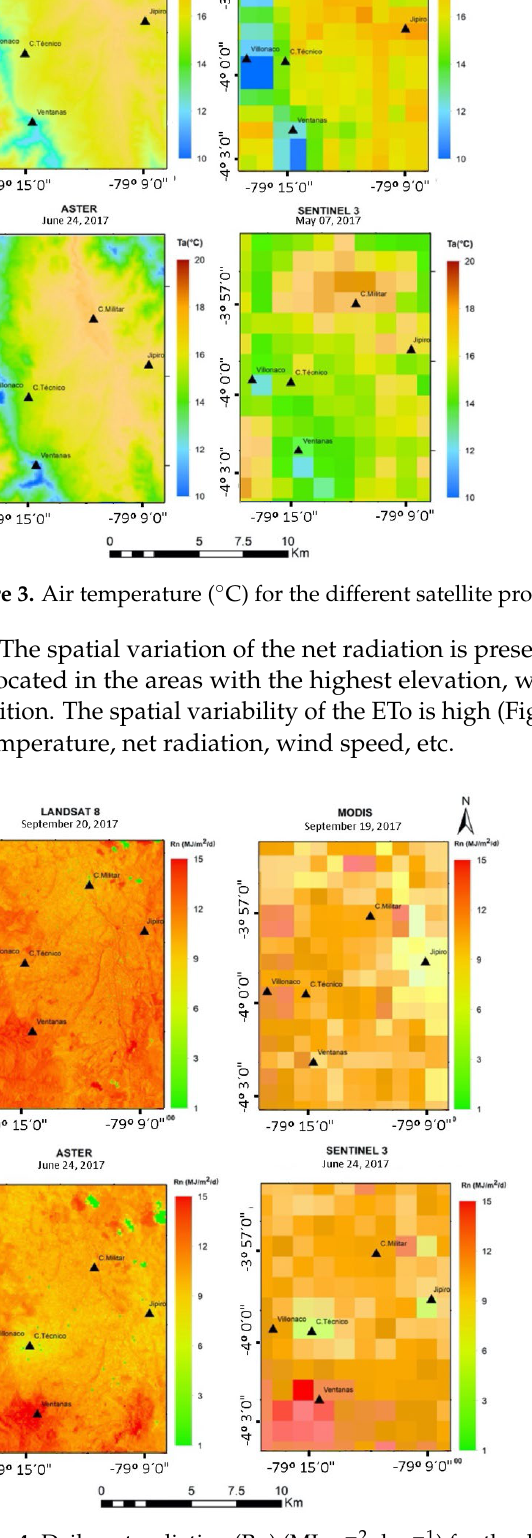
Figure 4. Daily net radiation (Rn) (MJ m −2 day −1 ) for the different products.